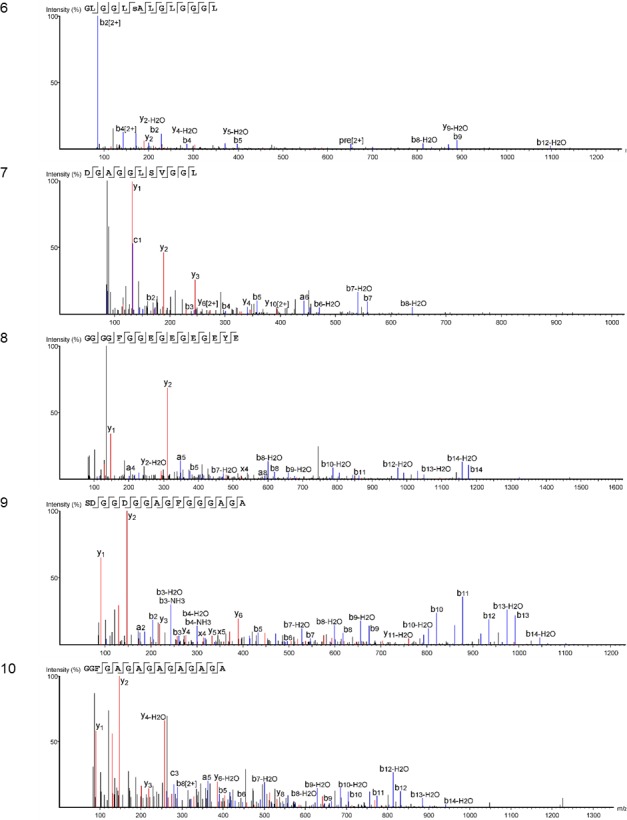
Product on spectra [6 -10] supporting the coverage of protein Hic74 identified in the double-button HavC.